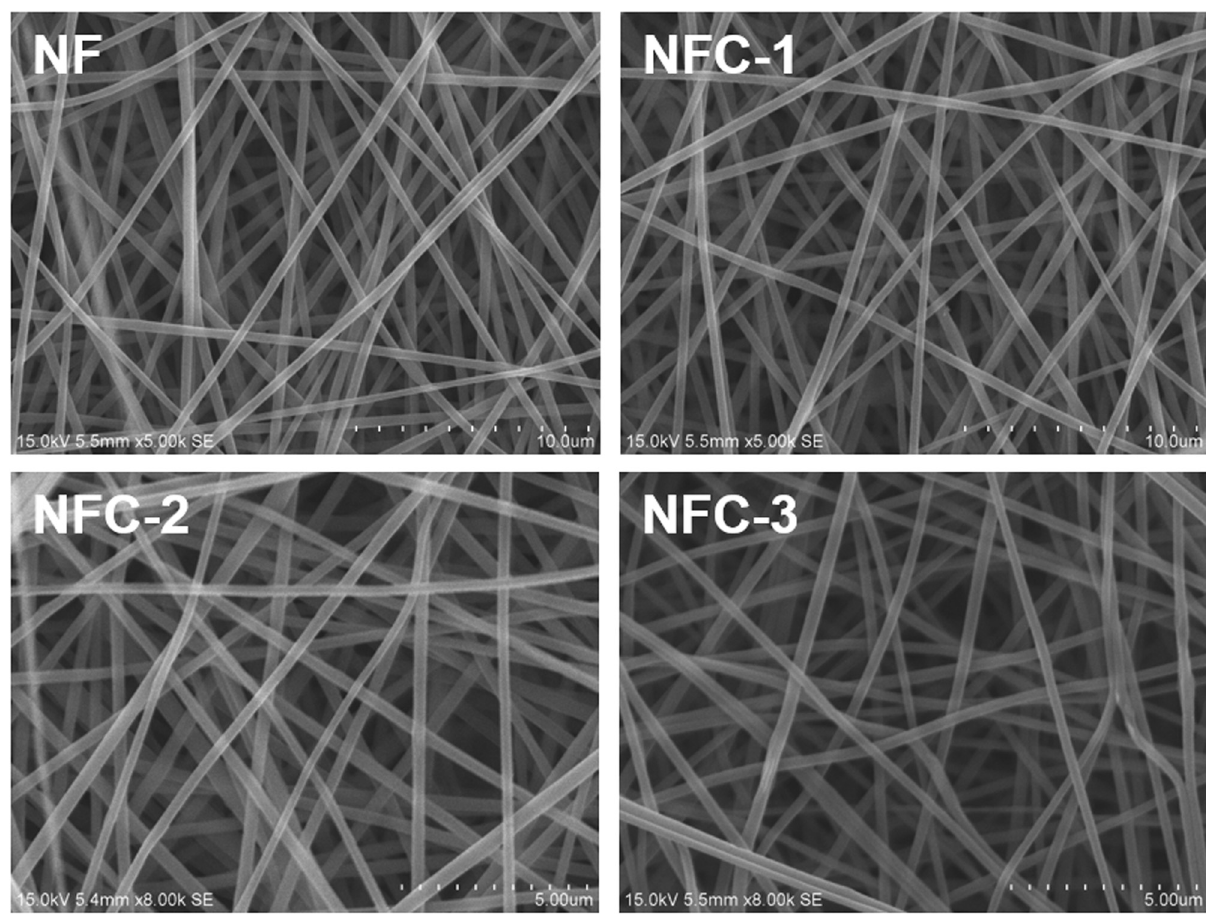
Figure 8: SEM pictures of NF and NFC nano fi brous